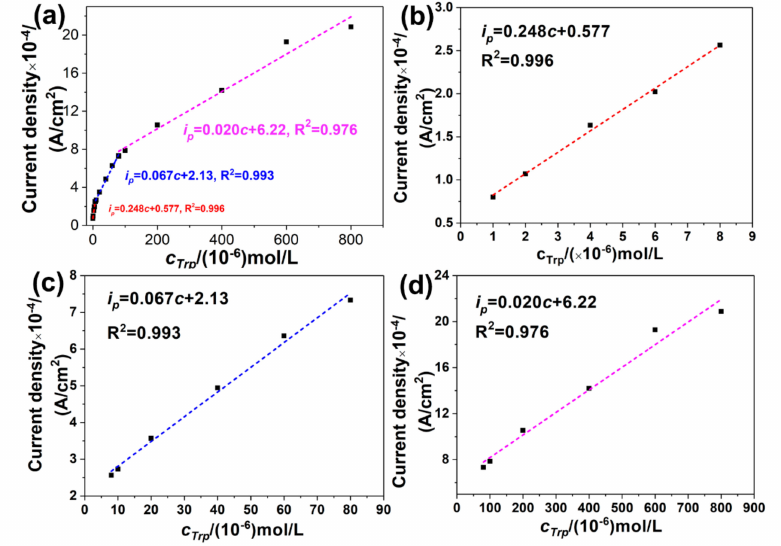
Figure 8. Three linear relationship of tryptophan in the range of 1.0 × 10 − 6 ~8.0 × 10 − 4 mol / L ( a ), the linear relationship of tryptophan in the range of 1 × 10 − 6 mol / L~8 × 10 − 6 mol / L ( b ), 8 × 10 − 6 mol / L~8 × 10 − 5 mol / L ( c ), and 8 × 10 − 5 mol / L~8 × 10 − 4 mol / L ( d